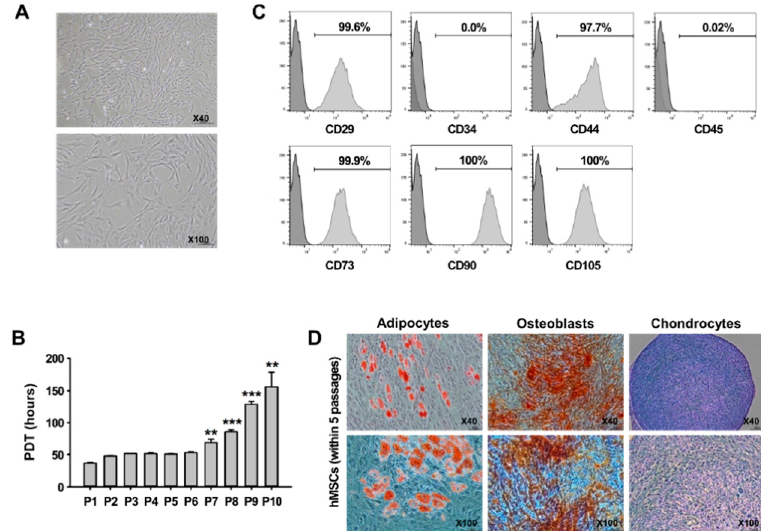
Figure 1. Characterization of human mesenchymal stem cells (hMSCs) derived from bone marrow (BM). ( A ) Morphology of cultured hMSCs in the early (within 5 passages, P5) phases. All hMSCs exhibited spindle-shaped morphology. ( B ) Analysis of population doubling time (PDT) of hMSCs within 10 passages. ** p < 0.01, *** p < 0.001 vs. P5 (two-sided paired t-test; n = 4 per group). ( C ) Immunophenotypic analysis for expression profiles of cell surface markers of hMSCs in the early phases. ( D ) Multi-lineage differentiation capacity of hMSCs. Differentiation of hMSCs into adipogenic, osteogenic, and chondrogenic lineages was stimulated then the differentiated cells stained with either oil red O (left, adipocytes), alizarin red (middle, osteoblasts), or alcian blue (right, chondrocytes).